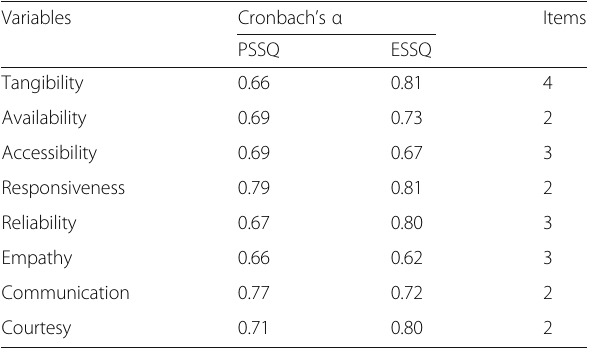
Table 2 Socio-demographic characteristics of the full